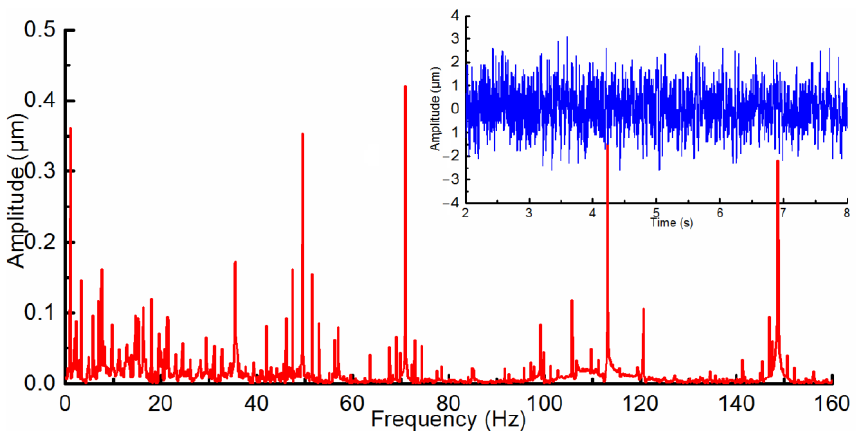
Figure 7. The spectral diagram of the displacement fluctuation of the direct drive feed system in the machining process.